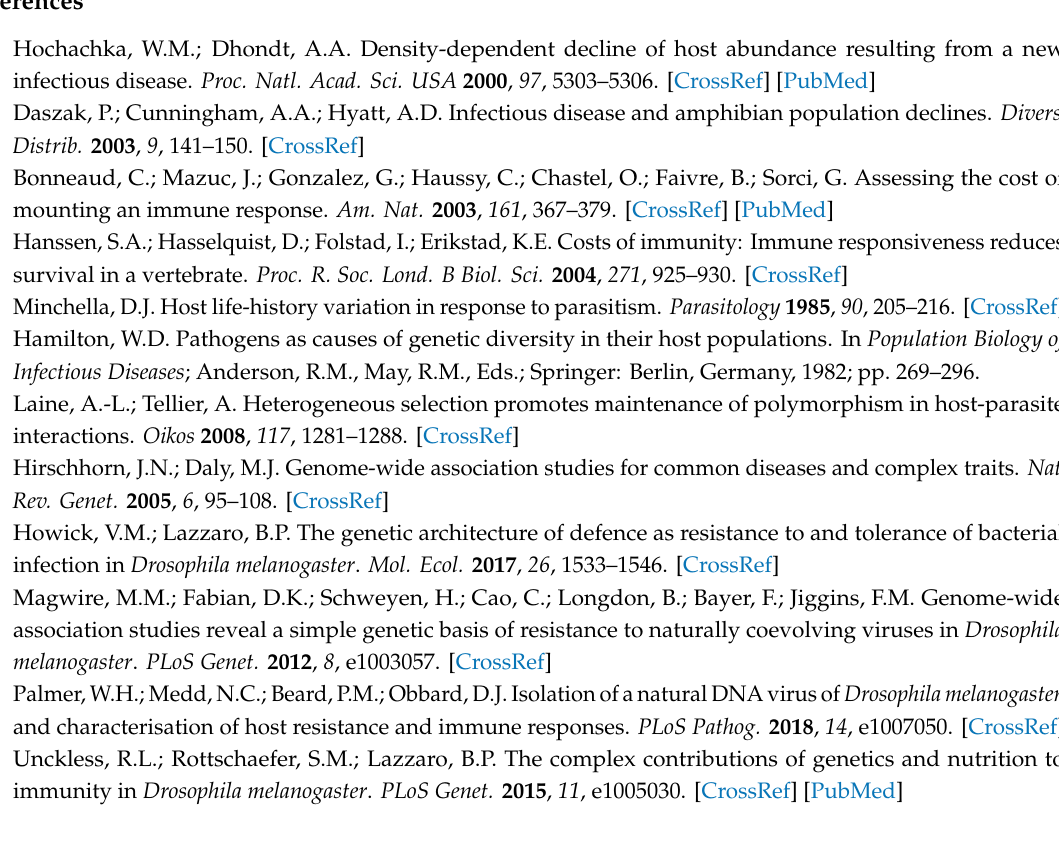
Figure S1: GWAS analysis data, Figure S2: Manhattan plot of genetic variants in an 18 kb window on chromosome 3L, Figure S3: Survival of GOIs (left panel) or neighbor genes (right panel) compared to empty cassette controls, Figure S4: Manhattan plot of genetic variants within the Bomanin cluster on chromosome 3L, Table S1: List of genetic variants with significant GWAS hits ( p < 10 − 7 ), Table S2: List of candidate genes and controls and Table S3: List of Bomanin lines used in this